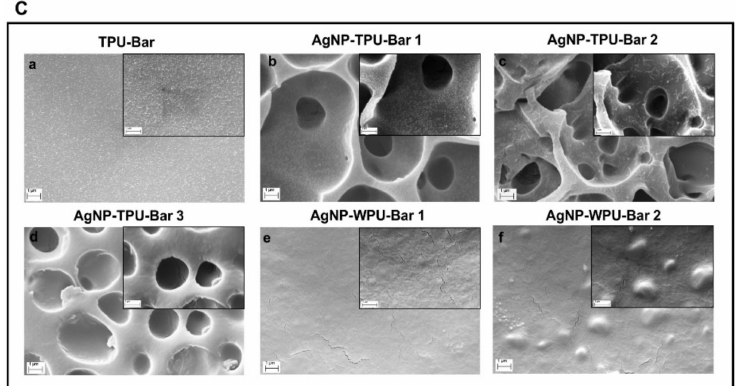
Figure 5. SEM images of thermoplastic polyurethane (TPU) and waterborne polyurethane (WPU) polymeric films at 20 kX (scale bar 1 µ m), insert in the right corner at 40 kX (scale bar 1 µ m). Panel ( A ): TPU and casted films; panel ( B ): brush films; panel ( C ): bar coater